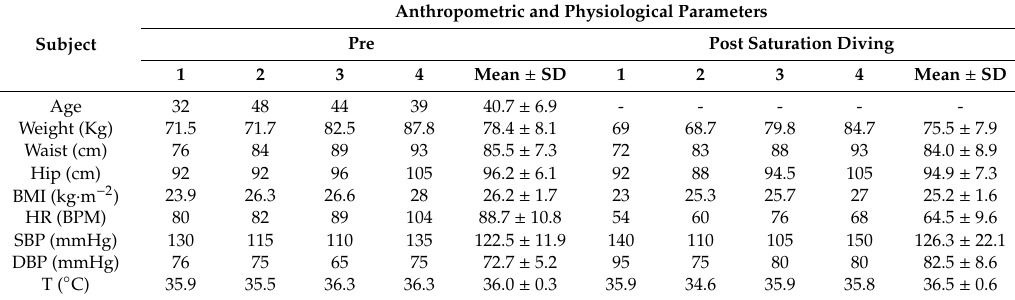
Table 1. Anthropometric and physiological parameters of all saturation divers. Parameters collected from the divers at pre- and post-saturation diving. BMI: body mass index; HR: heart rate; SBP: systolic blood pressure; DBP: diastolic blood pressure; T: